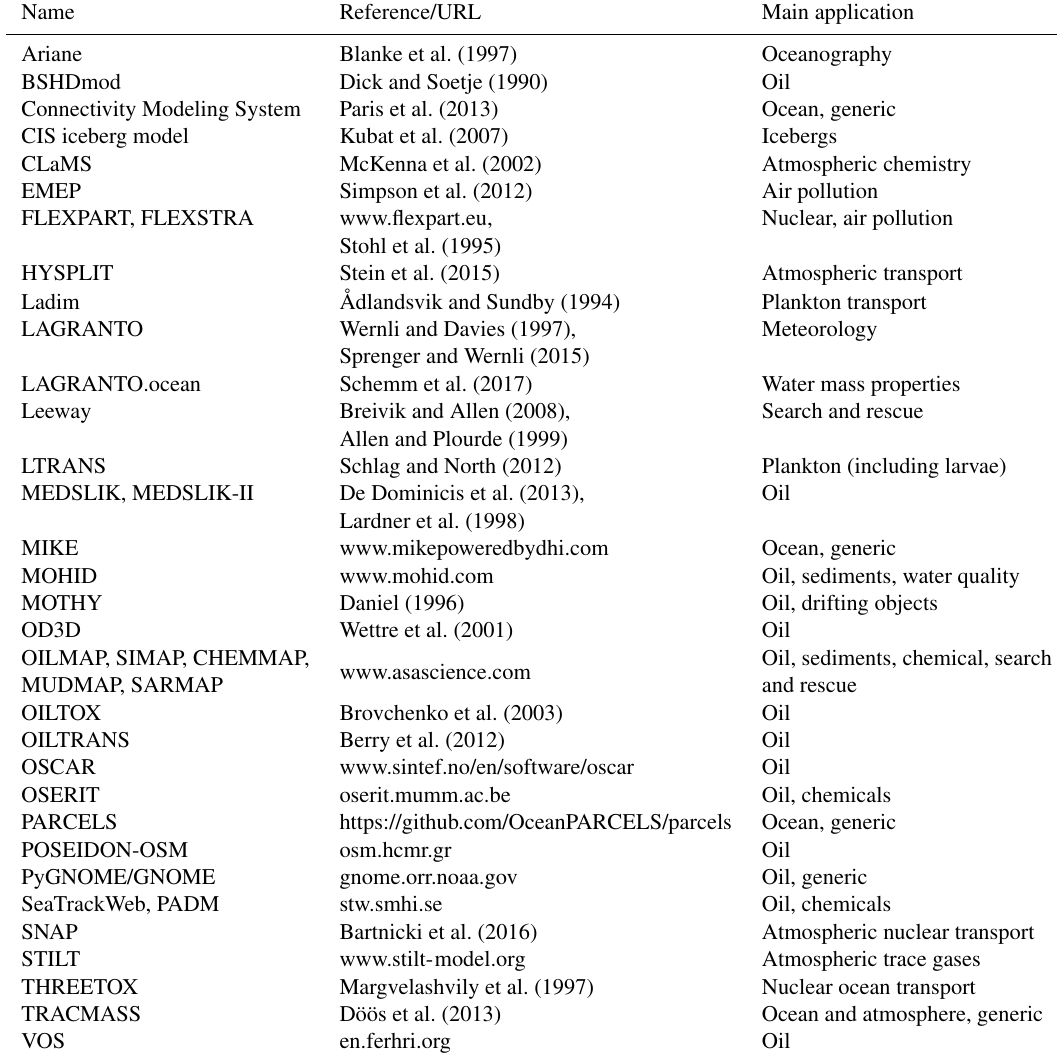
Table 1. Some existing trajectory models for various oceanic and atmospheric